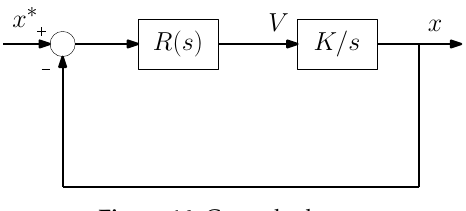
Figure 16. Control